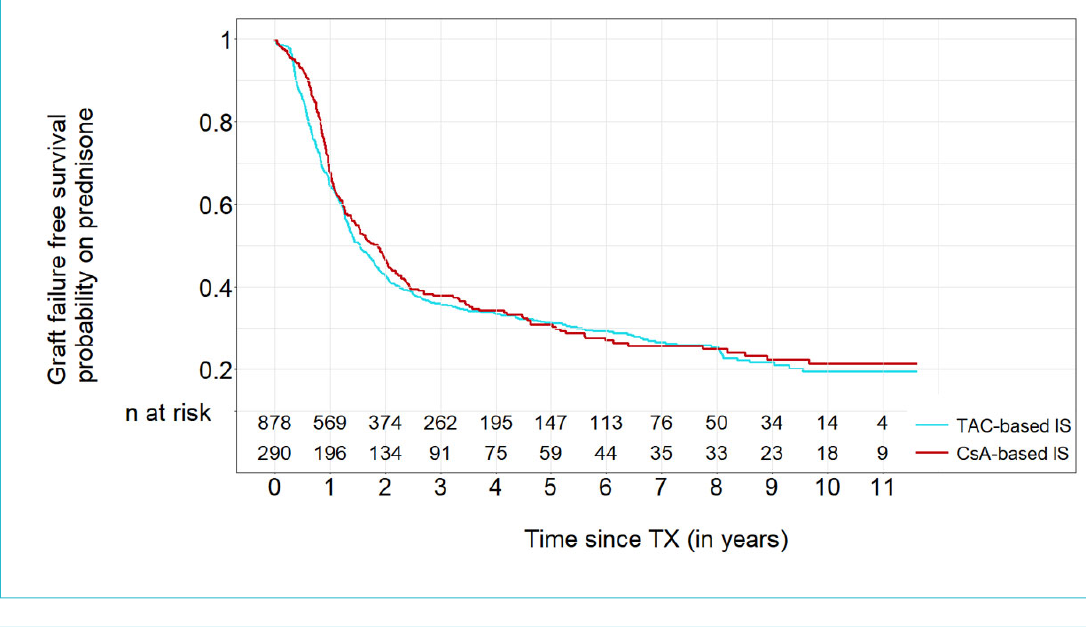
Figure 3: Median age of renal transplant recipients and organ donors between 2008 and 2017.